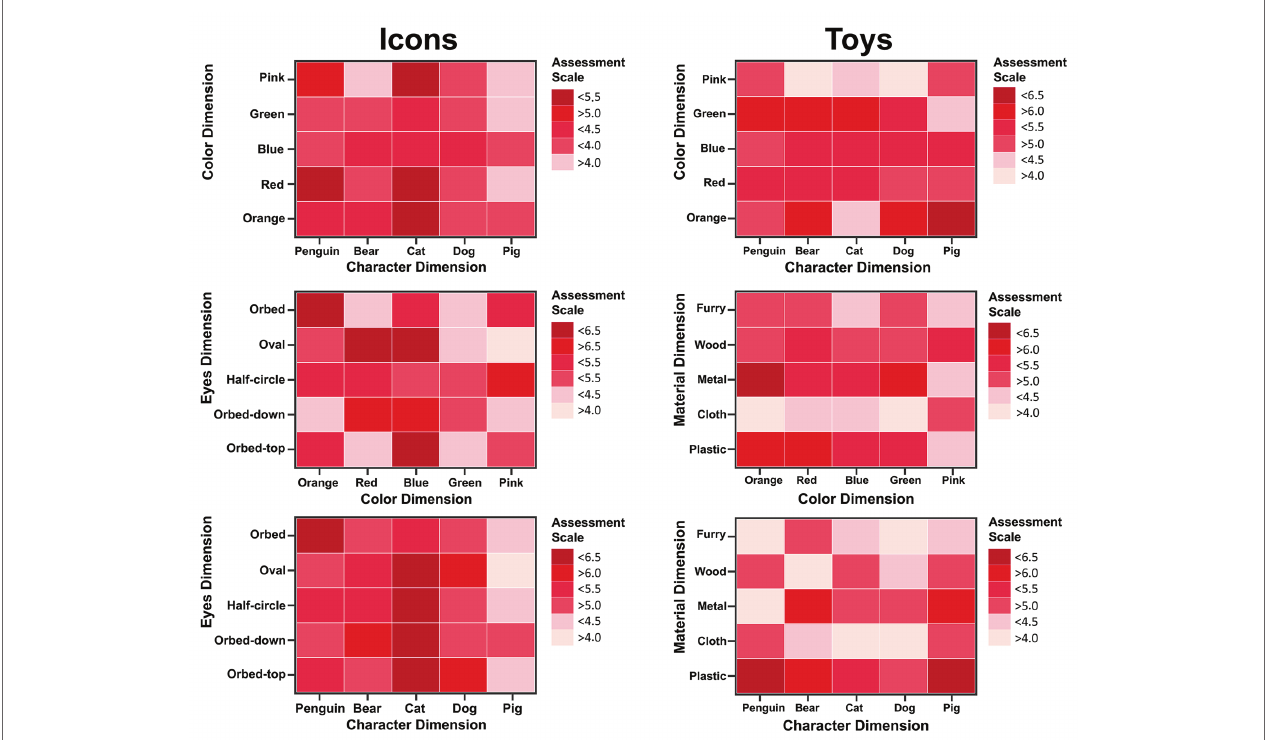
FIGURE 5 | Graphs of results for the assessment of the design dimensions of the icons (left column) and toys (right column) .